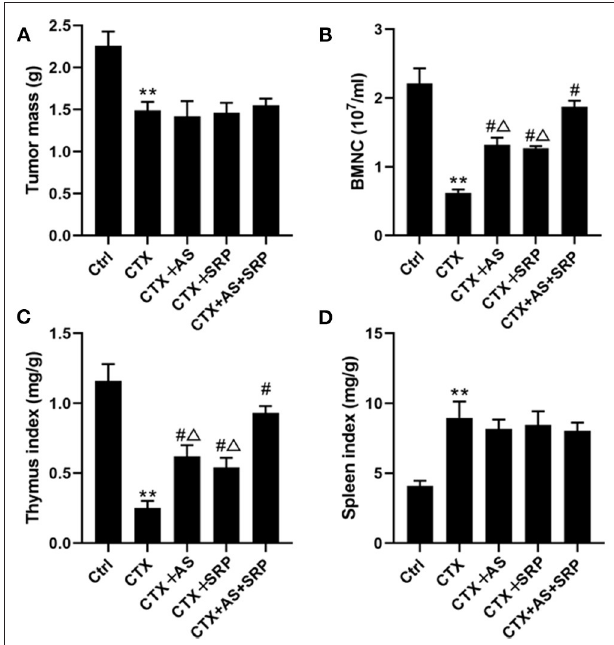
FIGURE 5 | Astragaloside IV (AS) and saponins of rhizoma polygonati (SRP) cures myelosuppression in vivo . Effect of AS and SRP on tumor mass (A) , bone marrow hematopoietic stem cell counts (B) , thymus index (C) , and spleen index (D) in lung cancer xenograft combined with cyclophosphamide (CTX)-induced myelosuppression in mice. ** P < 0.01 vs. Ctrl group; # P < 0.05 vs. CTX-alone group; 1 P < 0.05 vs. CTX + AS + SRP group; n = 10 or 5.